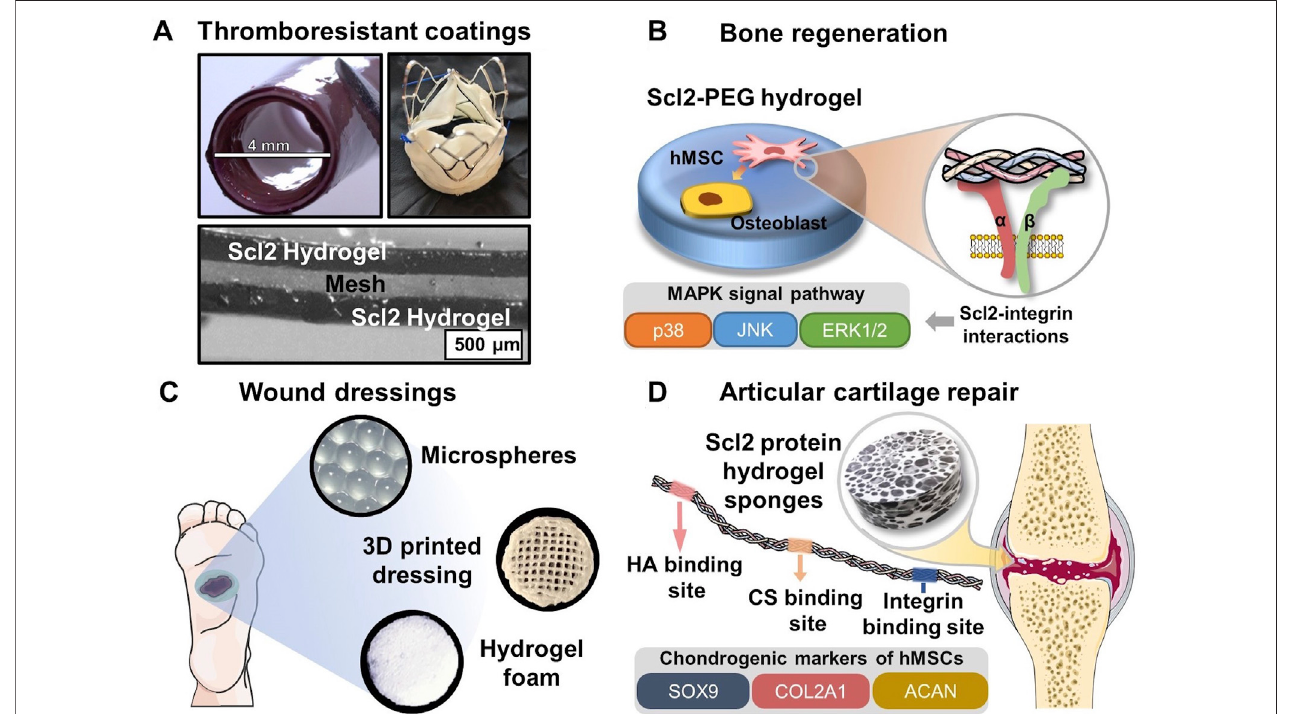
FIGURE 4 | Biomedical applications of Scl2-containing biomaterials with targeted integrin interactions. (A) PEG-Scl2 hydrogel coatings of cardiovascular devices toenhancethromboresistance; (B) PEG-Scl2hydrogelthatrevealedintegrin-mediatedhMSCosteogenicdifferentiationviatheMAPKsignalpathway (C) Differenttypes of dressings containing Scl2 proteins to enhance chronic wound healing; (D) PEG-Scl2 protein hydrogel with binding sites for chondroitin sulfate and hyaluronic acid to improve cartilage